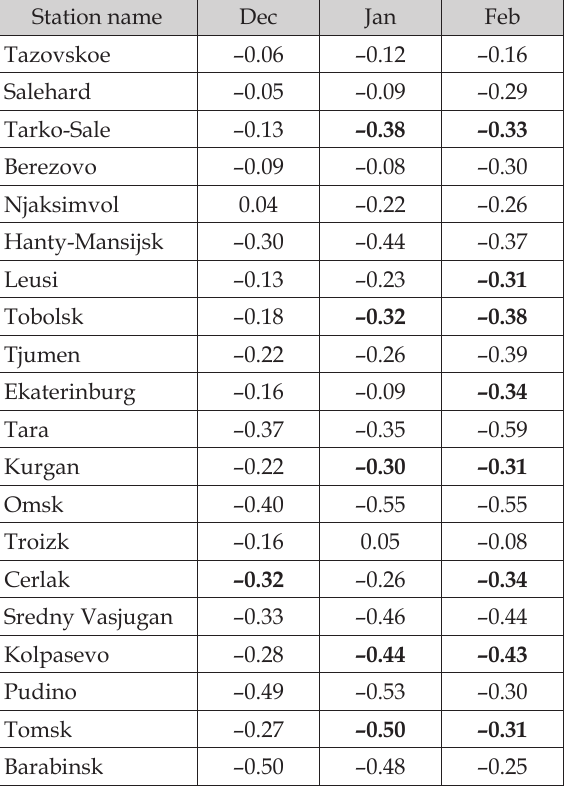
Table 1. Correlation coefficient between monthly in- creases in snow cover depth and Siberian High Index.